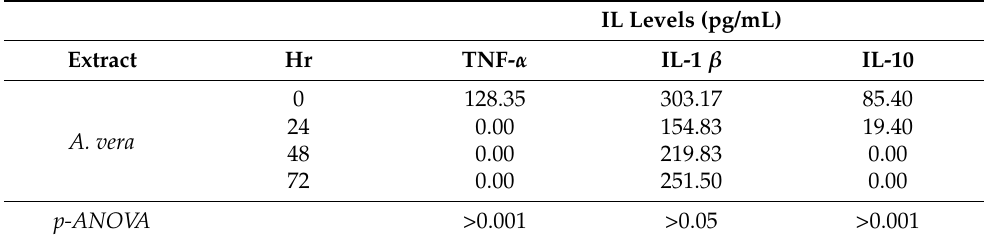
Table 7. Anti-inflammatory